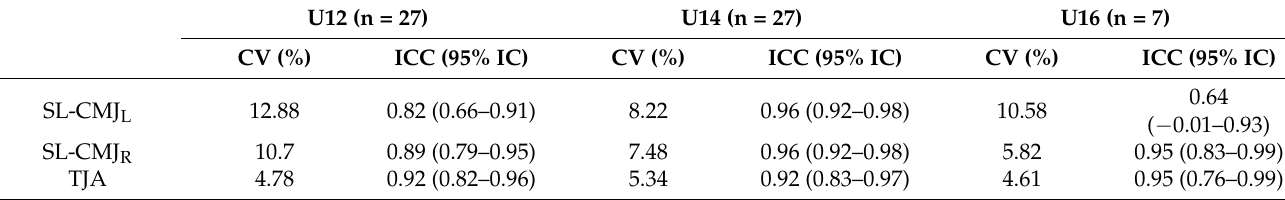
Table 4. Descriptive data of the participants (mean ± standard